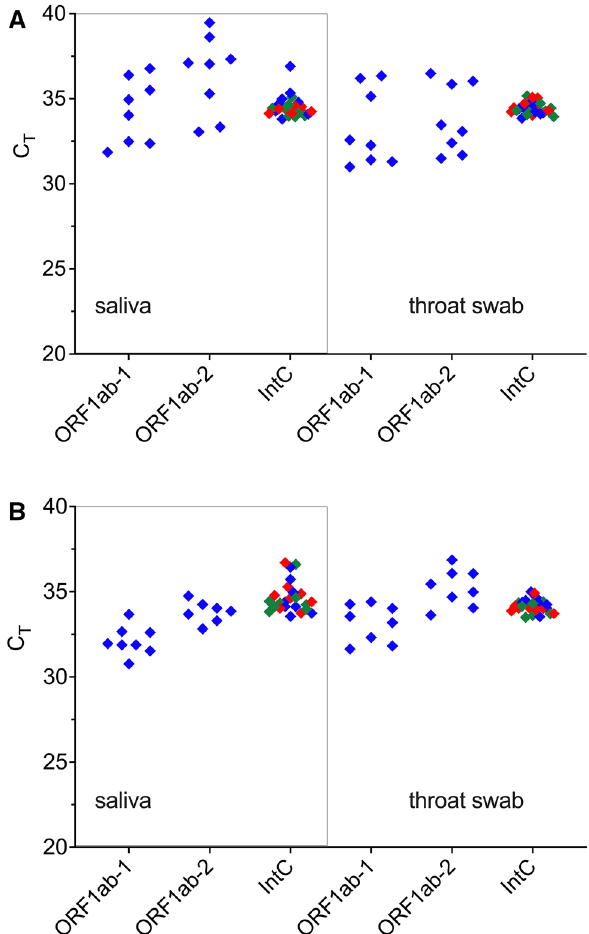
Figure 6. SARS-CoV-2 detection on hypothetical patient samples. Saliva and throat swab samples were collected from 24 volunteers and spiked 8 each with 1 × 10 5 copies/ml heat inactivated 2019 novel coronavirus (nCoV; blue diamond), VLPs (red diamond), or water (green diamond). Total RNA was extracted using ( A ) Opentron-2 and ( B ) Eppendorf epMotion. Biological samples were analysed by multiplex, probe-based RT-qPCR targeting SARS-CoV-2 ORF1a